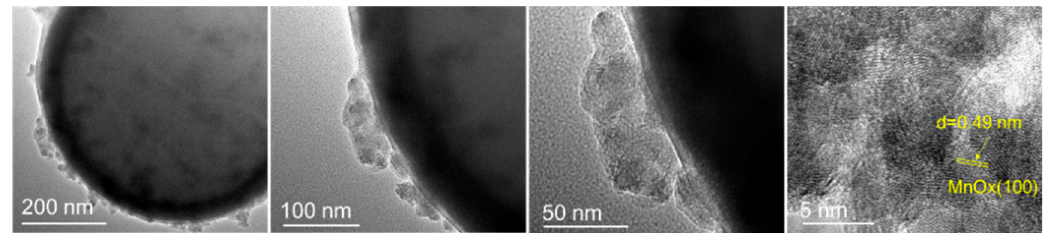
Figure 7. HR − TEM pro fi le of sample 0.05MnC − 30 − 500. Figure 7. HR-TEM profile of sample 0.05MnC-30-500.